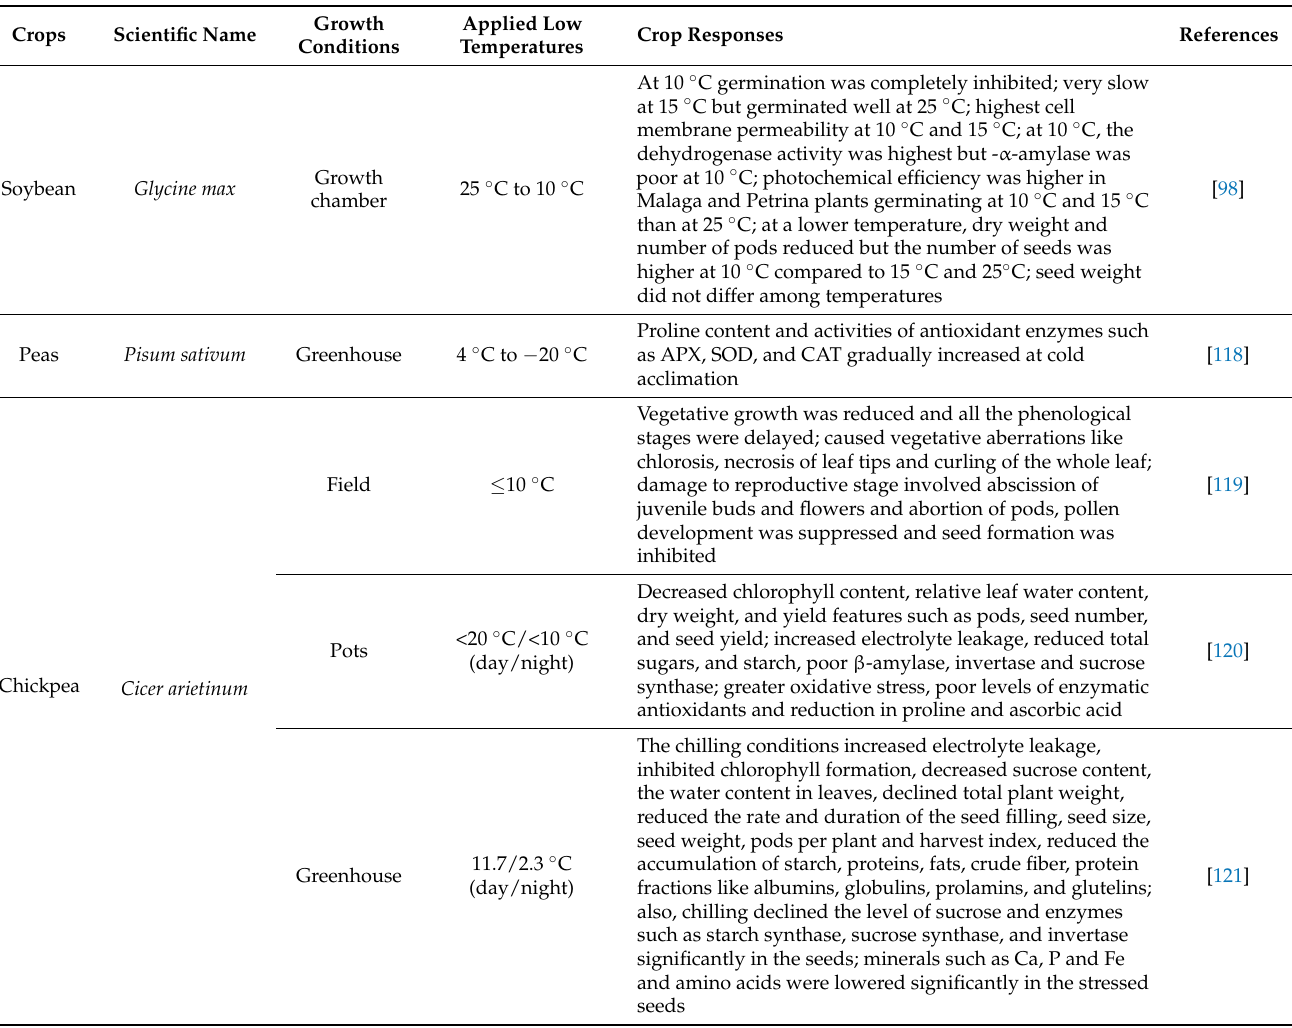
Table 1. Effect of low temperatures on biological and biochemical features of food